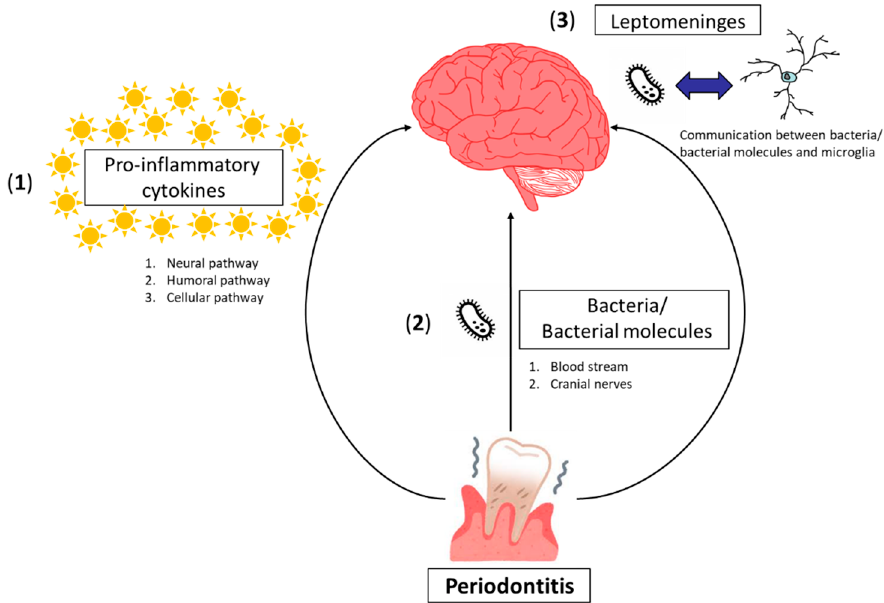
Figure 1. Scheme for presumed mechanisms by which periodontitis causes neuroinflammation. These consist of three possibilities as follows: ( 1 ) Peripheral pro-inflammatory cytokines associated with periodontitis communicate with the brain via the neural pathway, humoral pathway, and cellular pathway. ( 2 ) Periodontal bacteria/bacterial molecules can directly invade the brain either through the blood stream or via cranial nerves. ( 3 ) Communication between periodontal